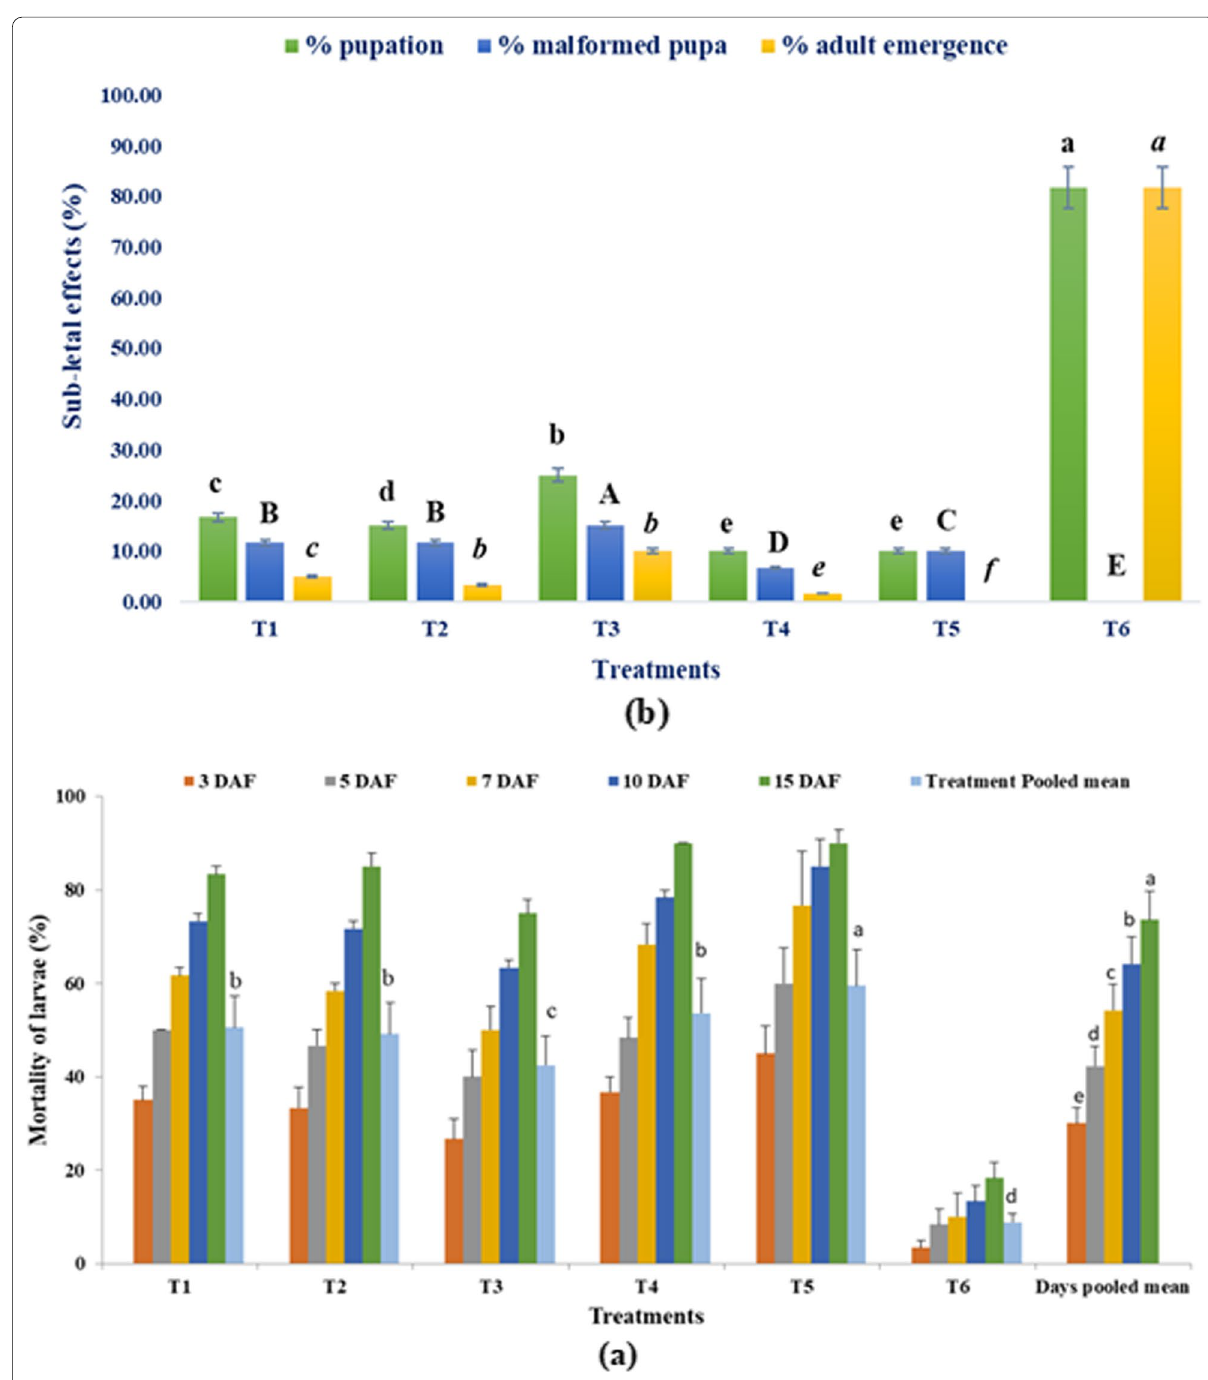
Fig. 5 Efficacy of endophytically colonized tomato plants by Beauveria bassiana UHSB-END1 on Spodoptera litura after 40 dpi a Larval mortality at different Days After Feeding (DAF) by 2nd instar larvae. Data are mean of three tests ( p ˂ 0.0001, f test) b Sub-lethal effects in in vivo assay. Mortality data are subjected to one-way ANOVA, and means are compared by DMRT (T1—seed treatment, T2—seedling root dip, T3—soil drenching, T4— foliar spray, T5—combination,